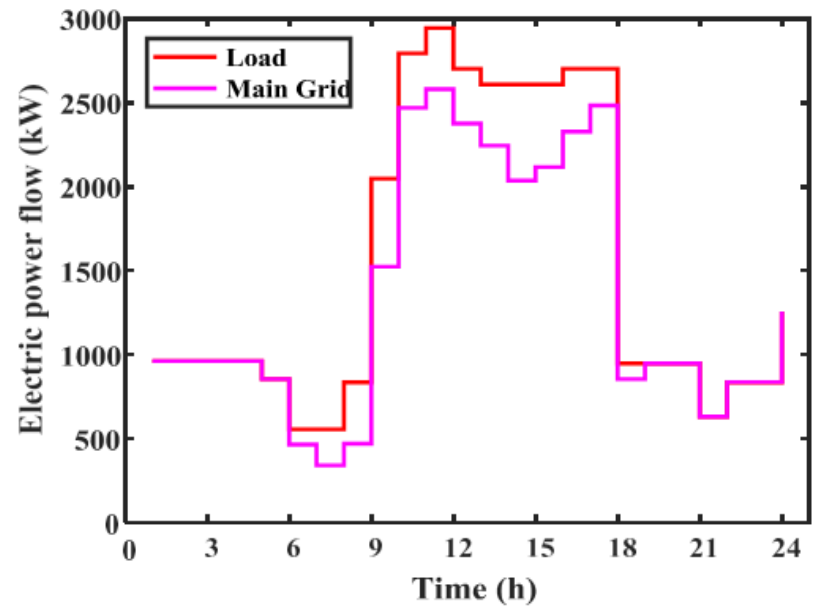
Figure 8. Electrical dispatch with DER & DR.